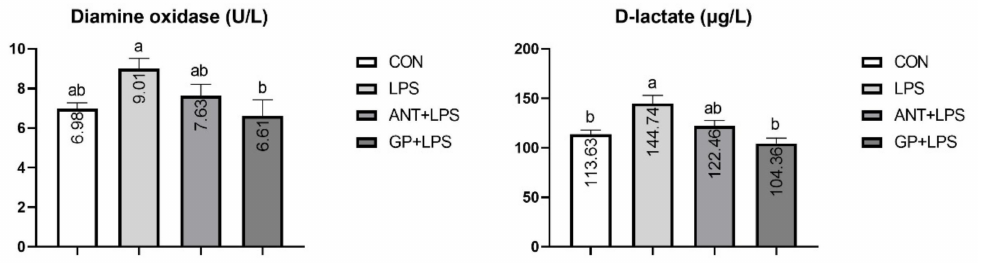
Figure 3. Effects of dietary garlic powder inclusion on serum diamine oxidase and D-lactate contents in broilers challenged with lipopolysaccharide (data were presented as mean and SEM, means that do not share the same superscript are significantly different, p <